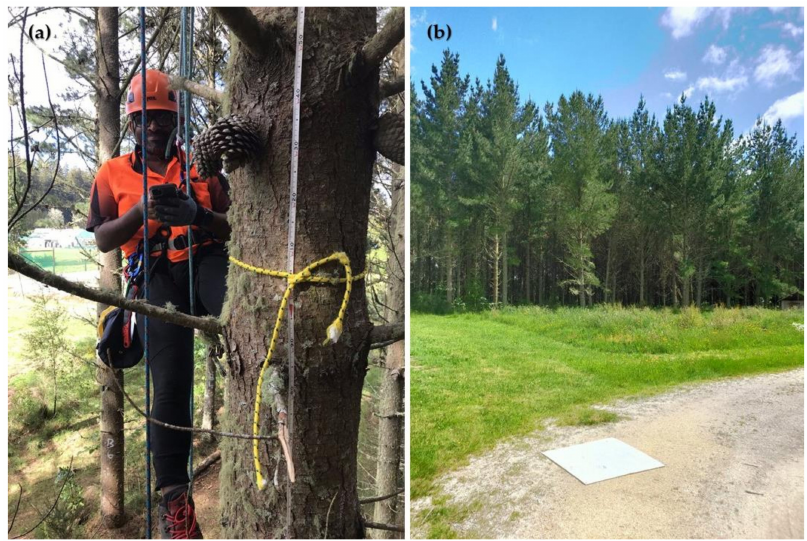
Figure 3. Images from the data capture showing ( a ) measurements being recorded to a mobile application during crown mapping and ( b ) a target deployed to the site as a ground control